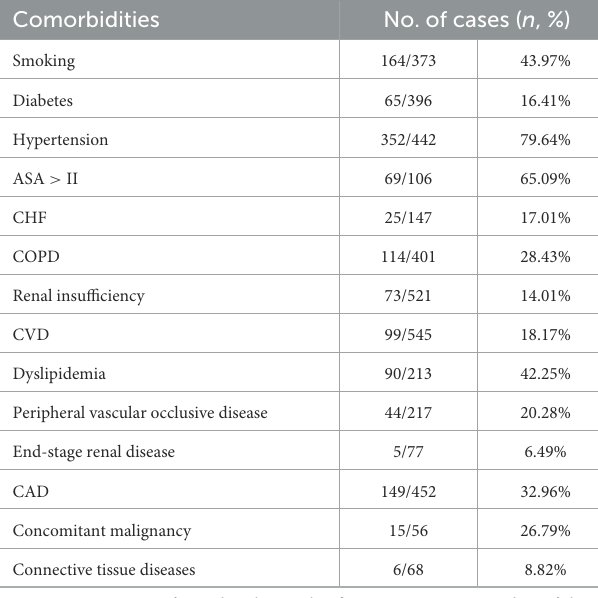
TABLE 3 Comorbidities in included